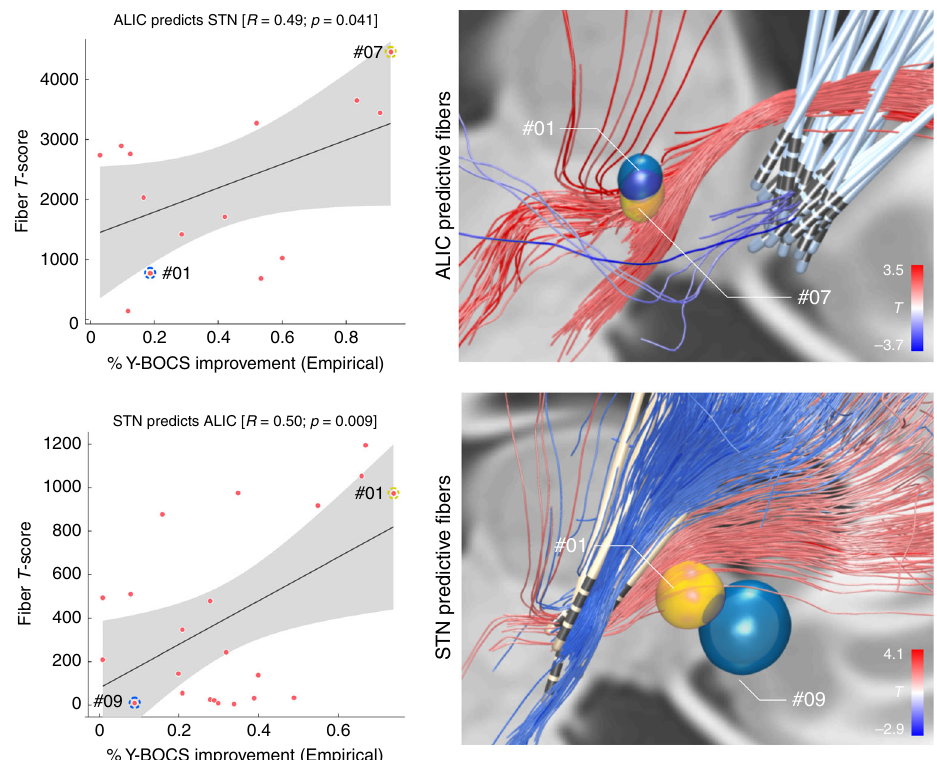
Fig. 3 Cross-prediction between ALIC and STN training cohorts. Top: when the tract was calculated exclusively based on data from the ALIC cohort, it was used to calculate fi ber T -scores for all patients in the STN cohort. These were correlated with clinical improvements in the STN cohort. One example patient with strong overlap of the tract (yellow) received a high fi ber T -score, whereas one with less overlap received a lower score (blue). The two example patients are marked in the correlation plot on the left. Bottom: here, the tract was calculated exclusively on data from the STN cohort to predict outcome in patients in the ALIC cohort. Again, two example patients are shown. Gray shaded areas in the correlation plots represent 95% con fi dence intervals. Of note, here, some VTAs barely overlapped with the tract (as the blue example VTA) and consequently received a near-zero